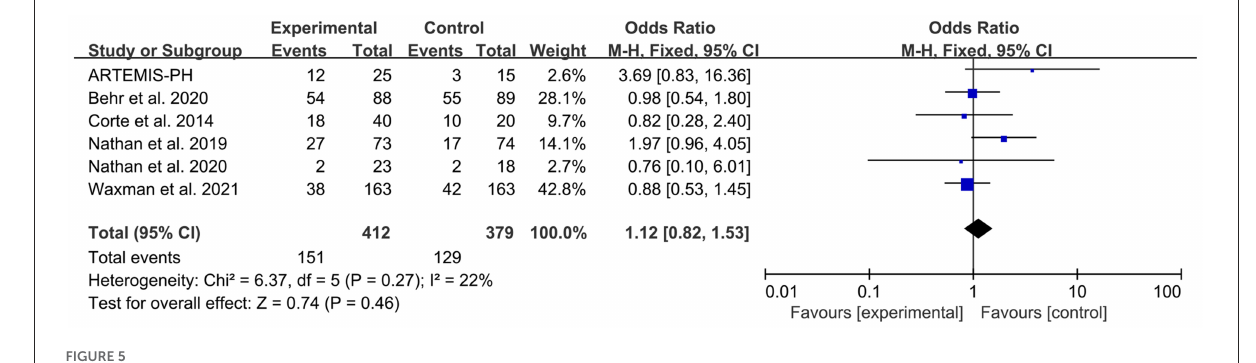
FIGURE5 Forest plot illustrating a comparison of any SAE in